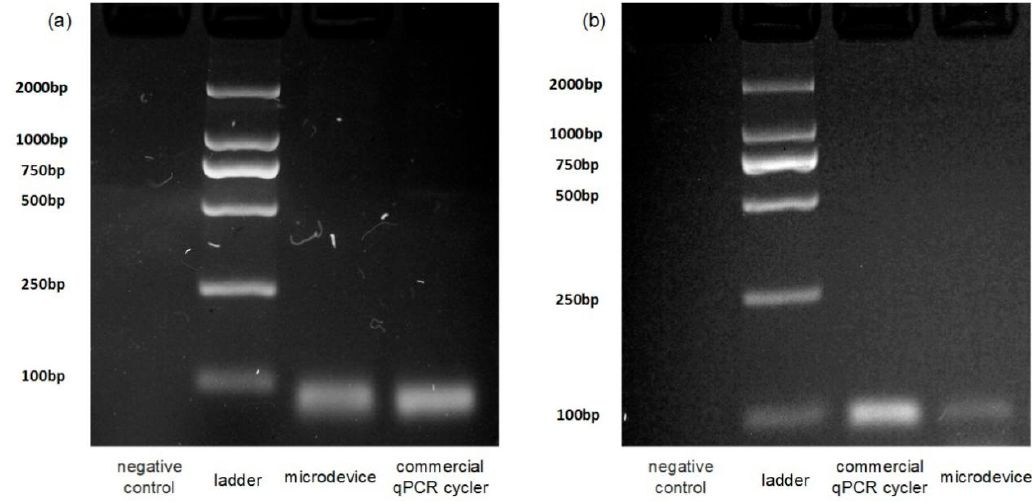
Figure 6. The electrophoretograms of ( a ) the DNA fragment of Human papillomavirus type 49 and ( b ) Rubella virus (RUBV).